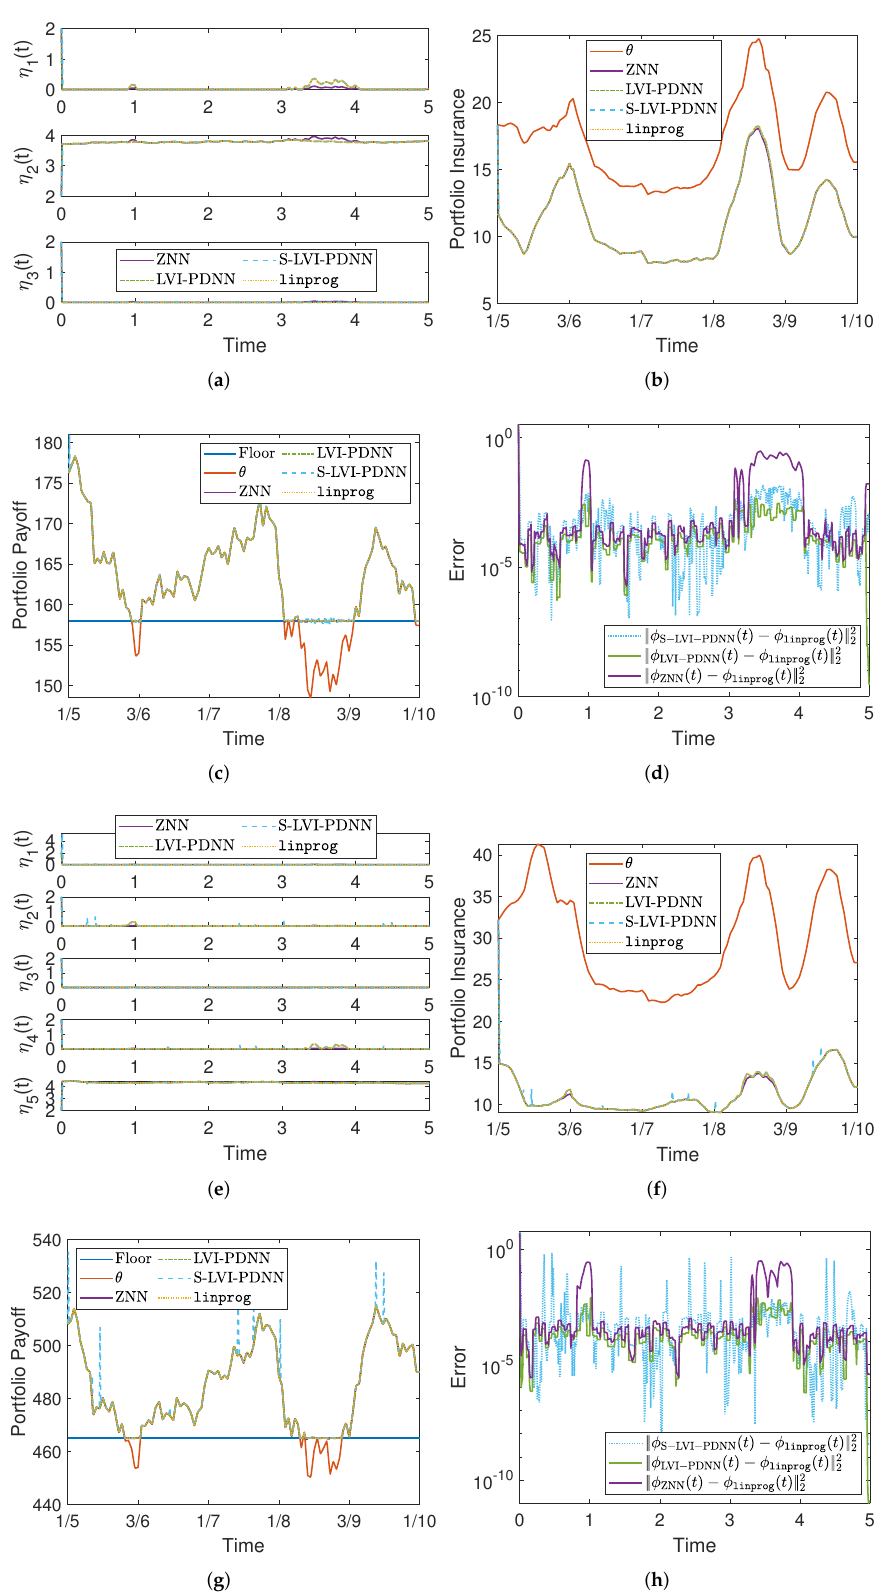
Figure 2. Portfolios’ weights, insurance costs, payoff, and the error between NNs and MATLAB’s linprog in cases 1 and 2. ( a ) Portfolios’ weights (case 1); ( b ) insurance costs (case 1); ( c ) portfolios’ payoff (case 1).; ( d ) error: NNs vs. linprog (case 1); ( e ) portfolios’ weights (case 2); ( f ) insurance costs (case 2); ( g ) portfolios’ payoff (case 2); ( h ) error: NNs vs. linprog (case